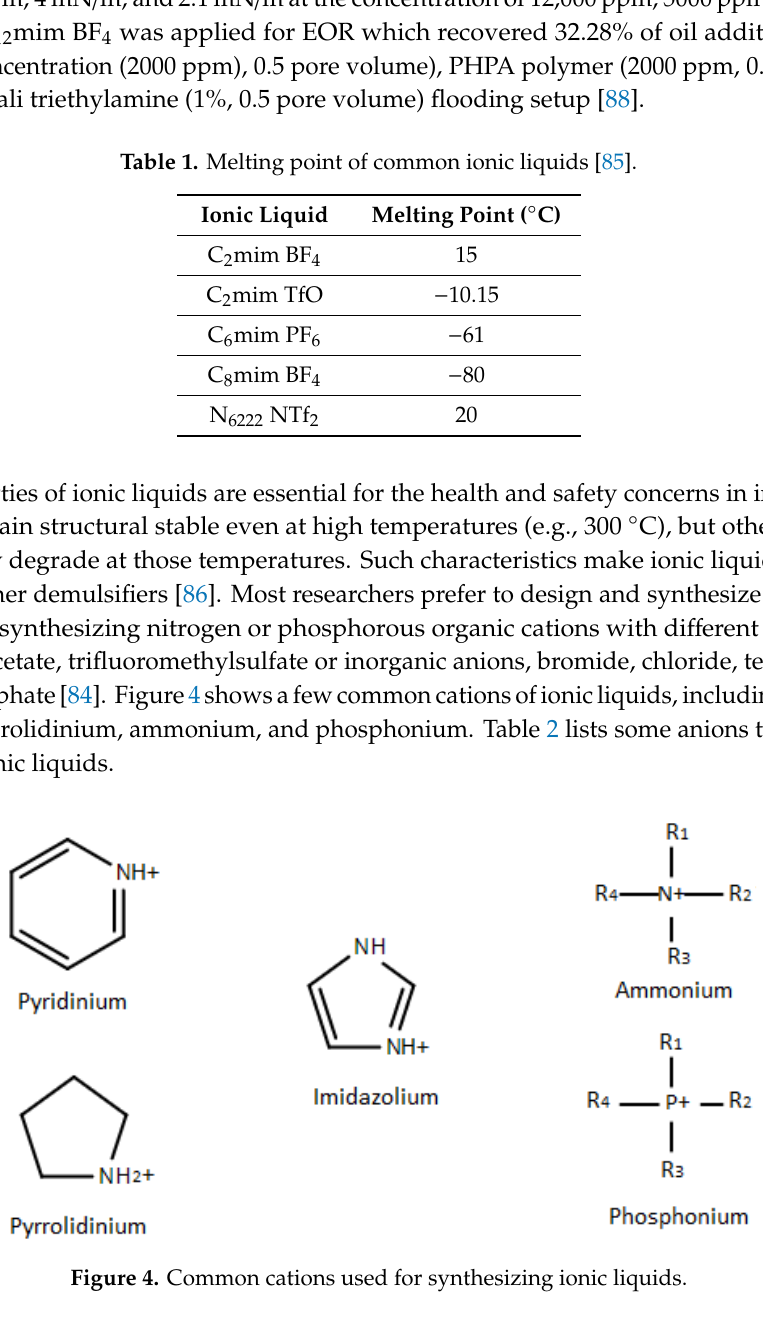
Table 1. Melting point of common ionic liquids [85].